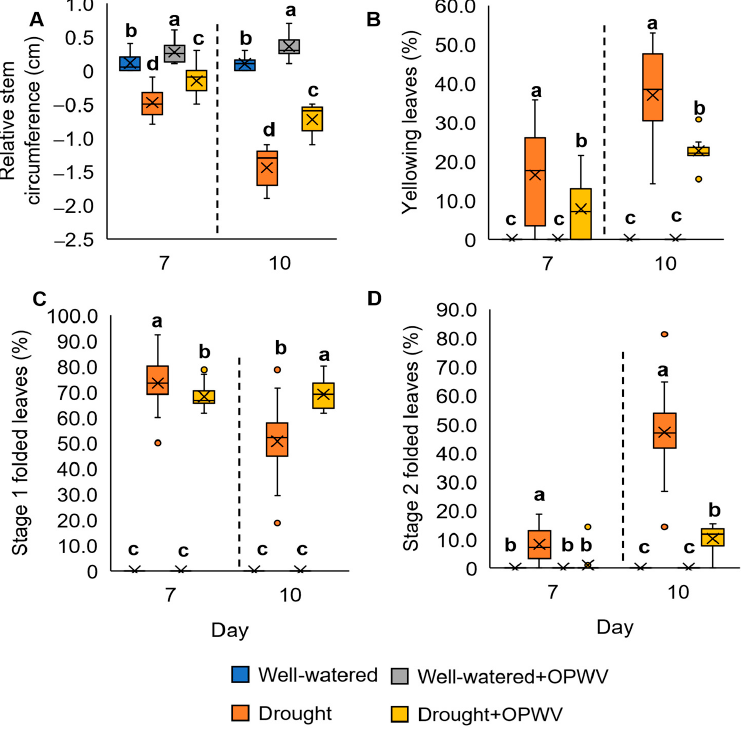
Figure 4. The stem and leaf morphological analyses of the Pandanus amaryllifolius treated with 1:500 diluted OPWV at 3-day intervals under well-watered and drought stress conditions for 7 and 10 days. ( A ) The relative stem circumference. ( B ) The percentage of yellowing leaves. ( C ) The percentage of Stage 1 leaf folding. ( D ) The percentage of Stage 2 leaf folding. The letter labelled on the mean value indicates a significant level between treatments based on the one-way ANOVA, followed by the post hoc Tukey test when its p -value < 0.05. The letter ‘a’ above the bars indicates the highest value, followed by ‘b’, ‘c’, and ‘d’. The ( × ) labelled in the box plot indicates the mean value of the treatment, while the ( • ) refers to the outlier value of the